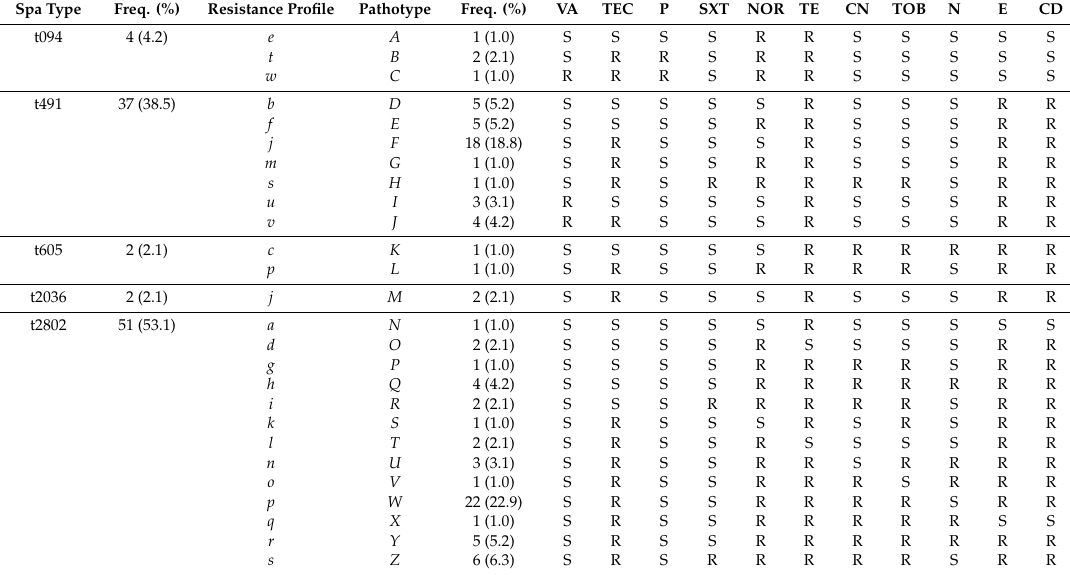
Table 2. Spa types associated to resistance profiles and pathotypes and their relative frequencies. All strains were susceptible to Amoxicillin-Clavulanate, Cefoxitin, Linezolid, Rifampin, and Quinupristin-Dalfopristin, so these antibiotics are not shown. Spa